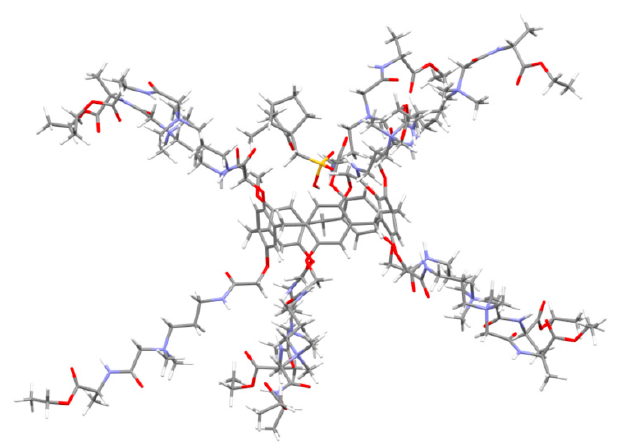
Figure 8. View of the energy geometry optimized complex formed by macrocycle 13 and (1S)-(+)-10-camphorsulfonic acid G2 , calculated by